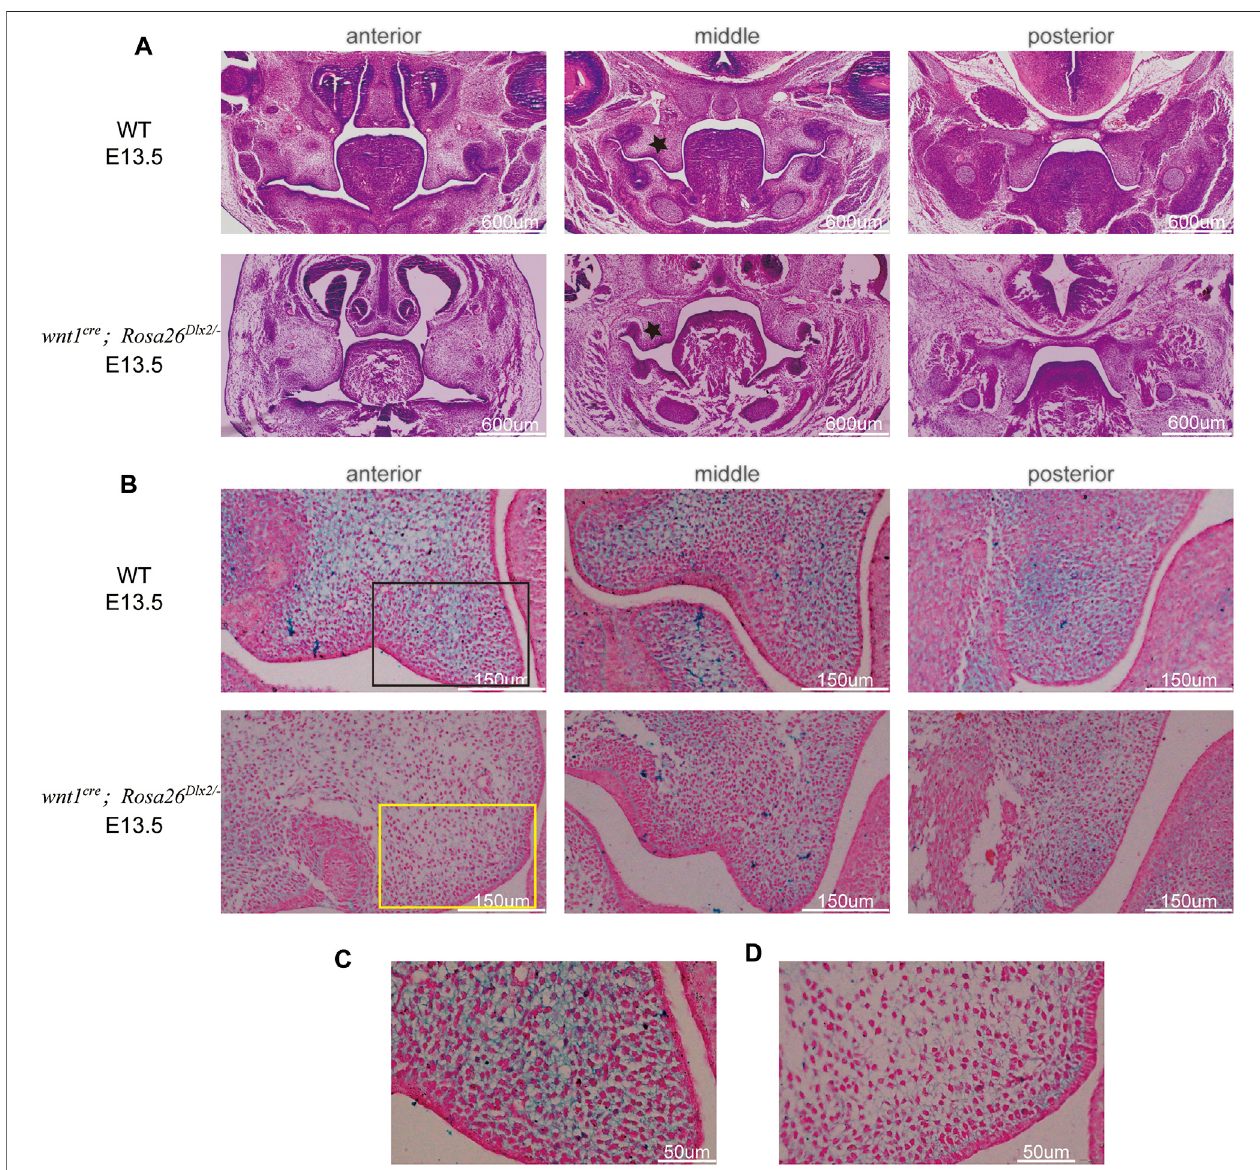
FIGURE 5 | Conditional Dlx2 overexpression in wnt1 cre ; Rosa26 Dlx2/- mice caused cleft palate by affecting maxillary growth and uplift (A) HE staining of frontal sectionsshowingthemorphologyofmaxillaryprocessesofWTand wnt1 cre ;Rosa26 Dlx2/- mouseembryosatE13.5.Themaxillaryprocessesofthe wnt1 cre ;Rosa26 Dlx2/- miceare smaller than thoseofWT.Blackstars indicate themaxillary processes (B) HAstainingofthe rightmaxillaryprocess at E13.5showing HAexpression in wnt1 cre ; Rosa26 Dlx2/- mice is decreased compared with WT mouse embryos (C,D) Locally enlarged palatal process sections display that HA fails to fi ll the ECM space and cell density is decreased in wnt1 cre ; Rosa26 Dlx2/- mouse embryos (C) Enlarged picture of the black box area in B (D) Enlarged picture of the yellow box area in B .